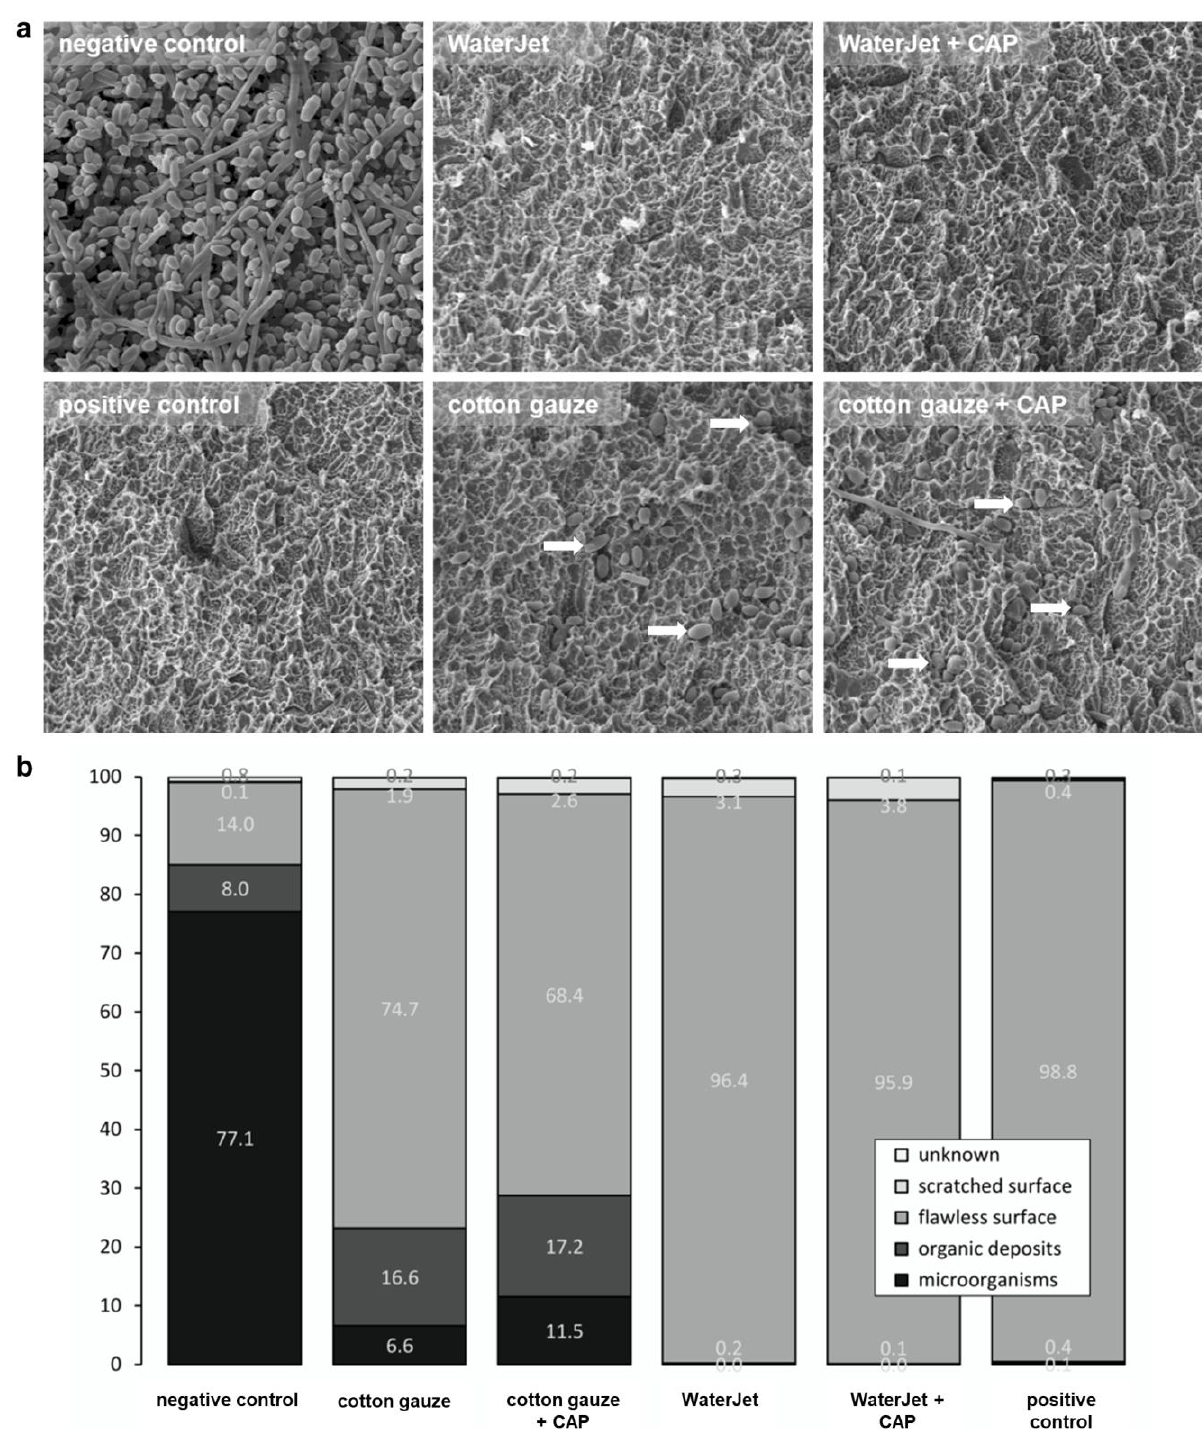
Figure 2. Implant SEM analysis. ( a ) scanning electron micrographs of implant surfaces of untreated samples (negative control), samples treated by WaterJet, cotton gauze, CAP, and sterilized samples (positive control), with white arrows indicating remaining microorganisms; ( b ) percentages of cross points with microorganisms, organic deposits, flawless surface, scratched surface, and unknown among all treatment conditions. Scale bars = 10 µm; white arrowheads show single bacteria.